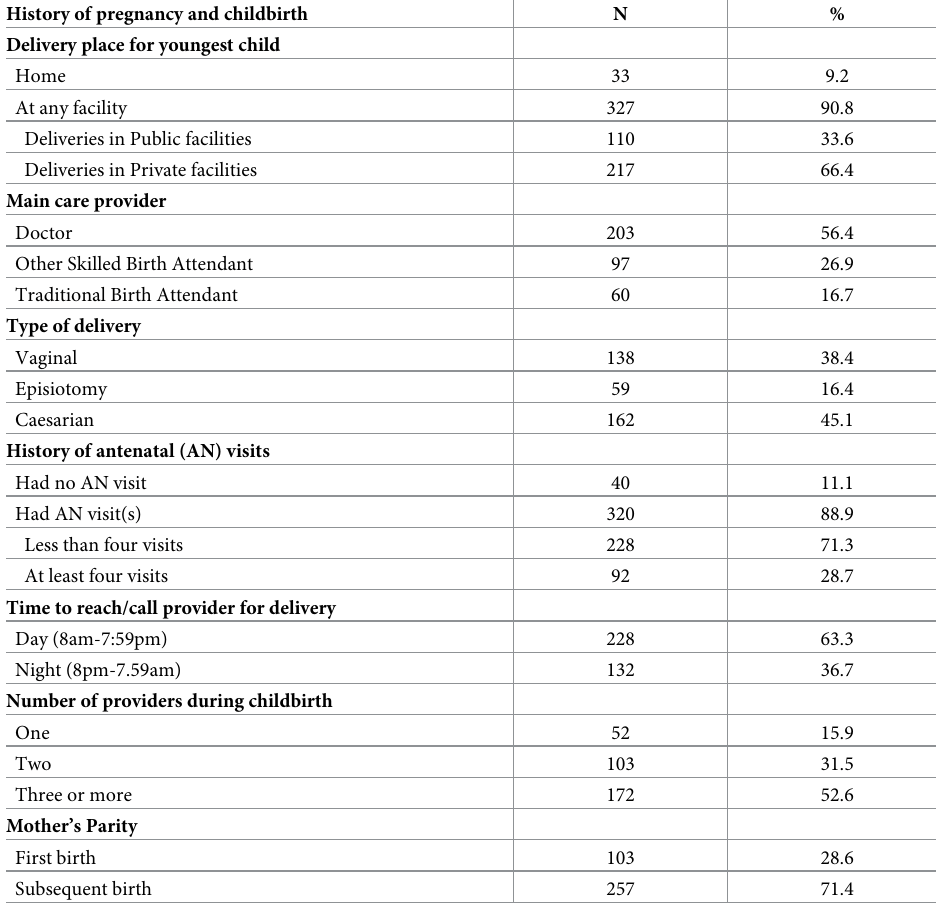
Table 2. History of antenatal care and